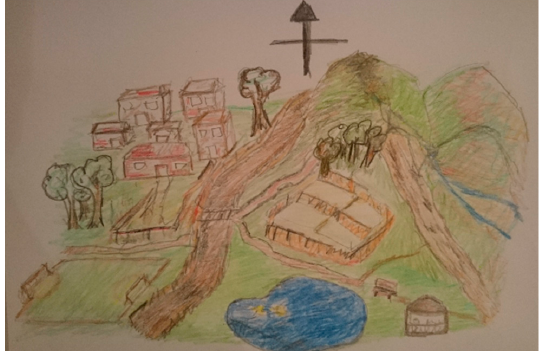
Figure 4. The tangible artefact for sharing (design: year 7 students).